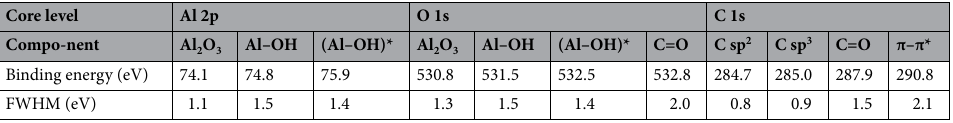
Table 2. Binding energies and full widths at half maximum (FWHM) of the core levels of Al 2p, O 1s, and C 1s of the